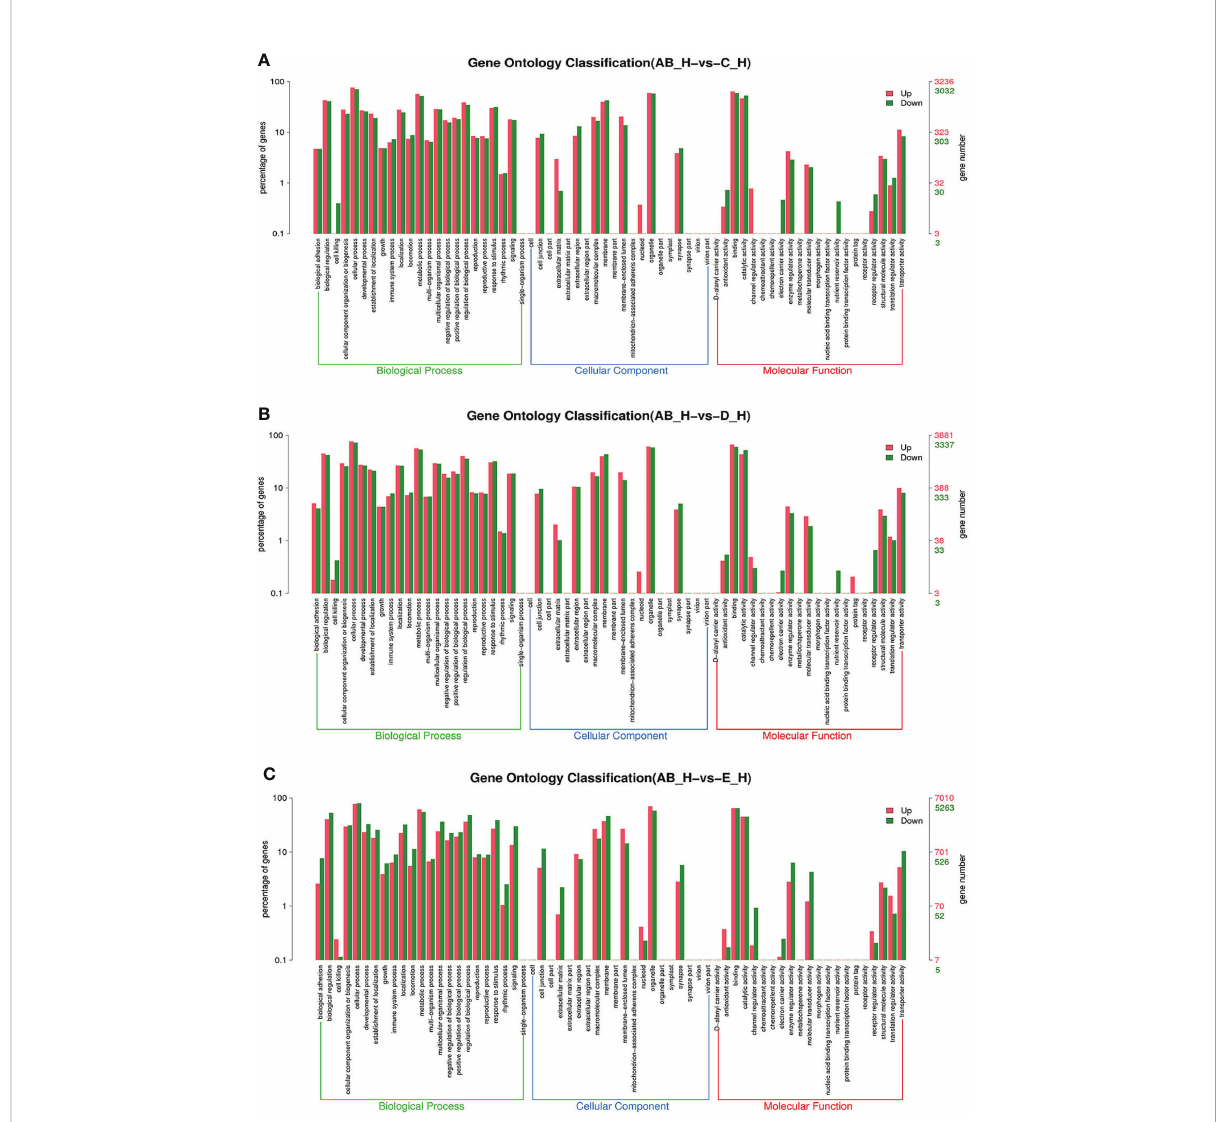
FIGURE 5 GO enrichment analyses of differentially expressed genes (DEGs) in hepatopancreas transcriptome. Notes: (A) Comparison between AB-H and C-H; (B) comparison between AB-H and D-H. (C) Comparison between AB-H and E-H. Notes: (1) AB-H: hepatopancreas from post-molt; C-H: hepatopancreas from inter-molt; D-H: hepatopancreas from per-molt; E-H: hepatopancreas from ecdysis. (2) Red columns indicate GO item entries enriched by upregulated differentially expressed genes; green columns indicate GO item entries enriched by downregulated differentially expressed genes. (3) The x -axis shows the item name between two stages, whereas the y -axis represents the number of genes and their percentage of the corresponding